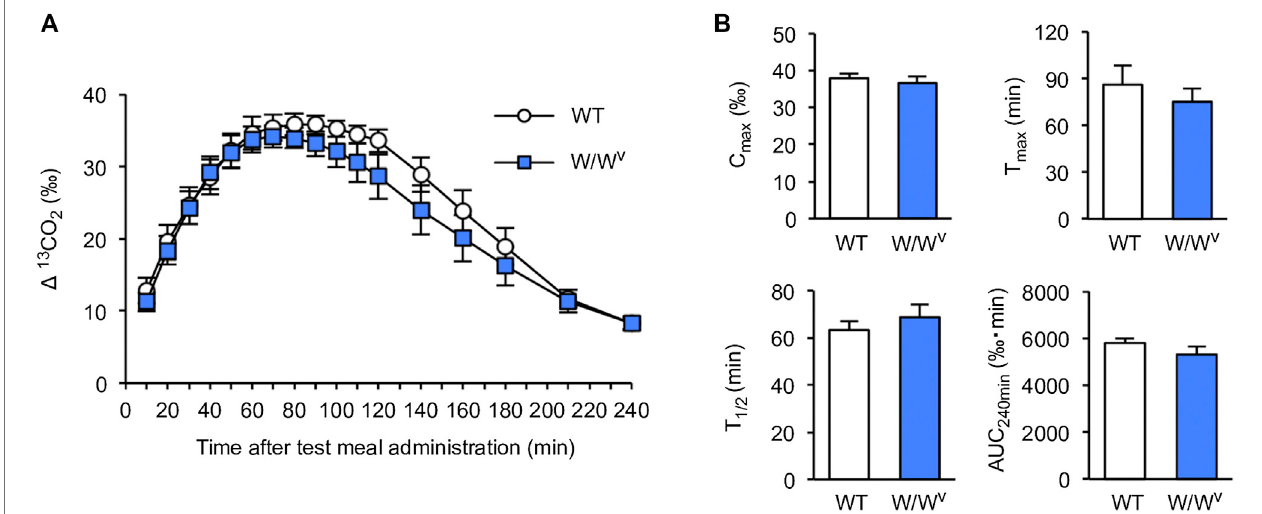
FIGURE1| Normalgastricemptyingin W / W v mice. (A) Timecourseofgastricemptyingmeasuredbythe 13 C-octanoicacidbreathtestinWTmiceand W / W v mice. The measurement wascontinued for 4 h after theadministration of thetest meal. (B) Quanti fi cation of C max , T max , AUC 240min , and T 1/2 calculated from (A) . Each column shows the mean ± SEM ( n (cid:2) 5 –